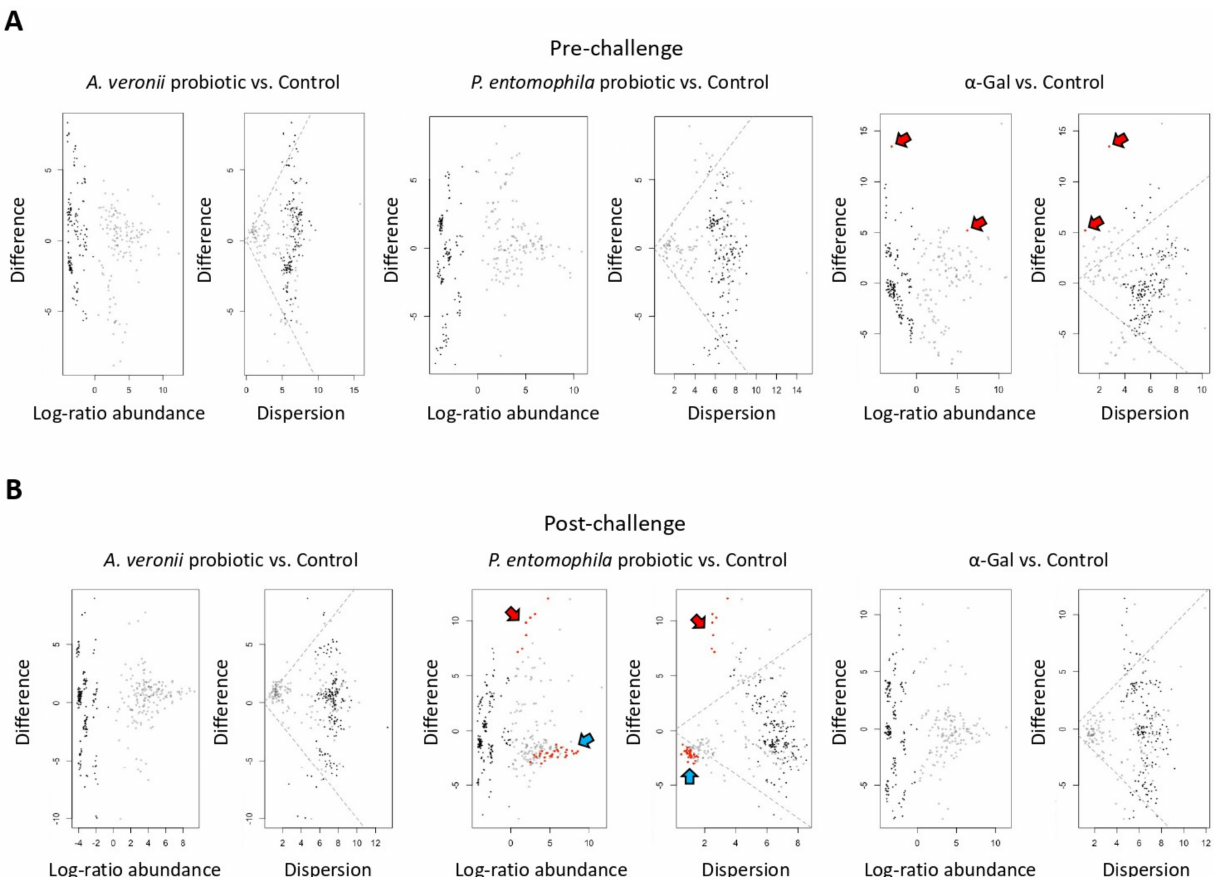
Figure 8. Differential abundance of bacterial taxa in zebrafish gut microbiota. ( A ) Taxa differential abundance of each treatment group vs. control at pre-challenge stage. ( B ) Taxa differential abundance of each treatment group vs. control at post-challenge stage. Taxa differential abundance was calculated with ALDEx2 and summarized in the effects size plots. The left MA plots (log-ratio abundance) show the relationship between abundance (log-ratio abundance is the clr value of each feature) on the x -axis and difference on the y -axis. The right plot (dispersion) is an effect plot that shows the relationship between difference and dispersion through the expected value of the log-difference between groups on the y -axis and the maximum within-group dispersion on the x -axis. In both plots, each point represents an individual ASV from the dataset at genus level. Taxa that are not significant are represented by gray or black points. Taxa that are statistically significant are represented by red points (Welch’s test, p < 0.05). Points marked with red arrows are more abundant in α -Gal treatment samples at pre-challenge stage or in P. entomophila probiotic treatment samples at post-challenge stage when compared to controls. Points marked with blue arrows are more abundant in control than in P. entomophila probiotic treatment samples at post-challenge